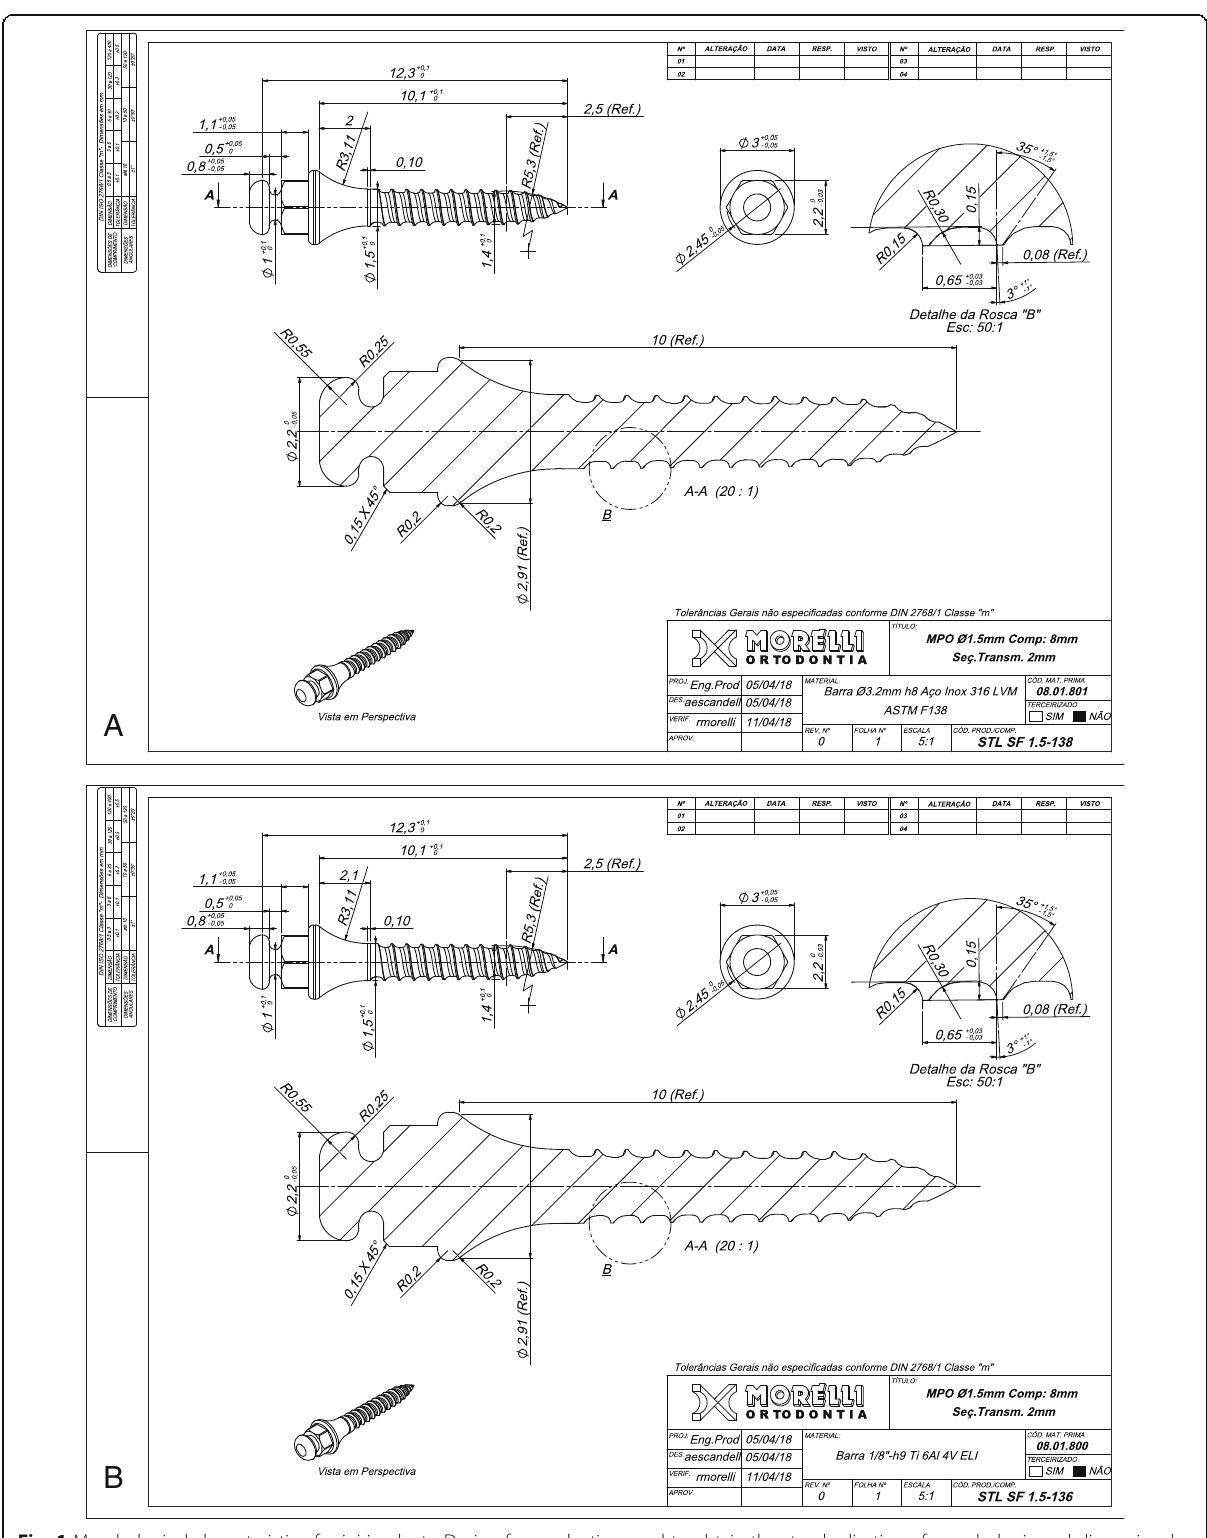
Fig. 1 Morphological characteristic of mini-implants. Design for production used to obtain the standardization of morphologic and dimensional characteristics of the SS-MIs ( a ) and TA-MIs ( b